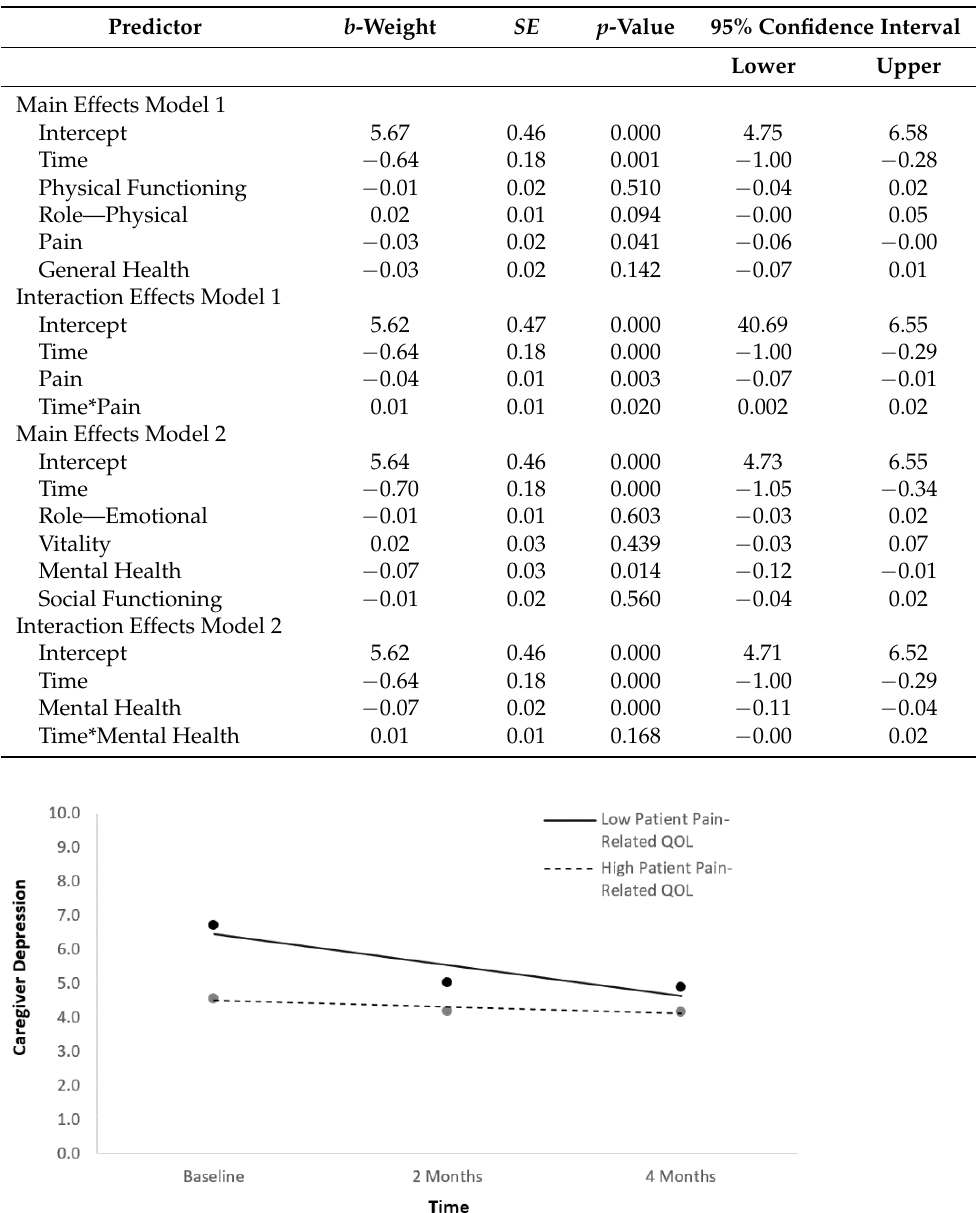
Table 3. Predictors of caregiver depression symptom trajectories at baseline, 2 months, and 4 months based on TBI HRQoL.